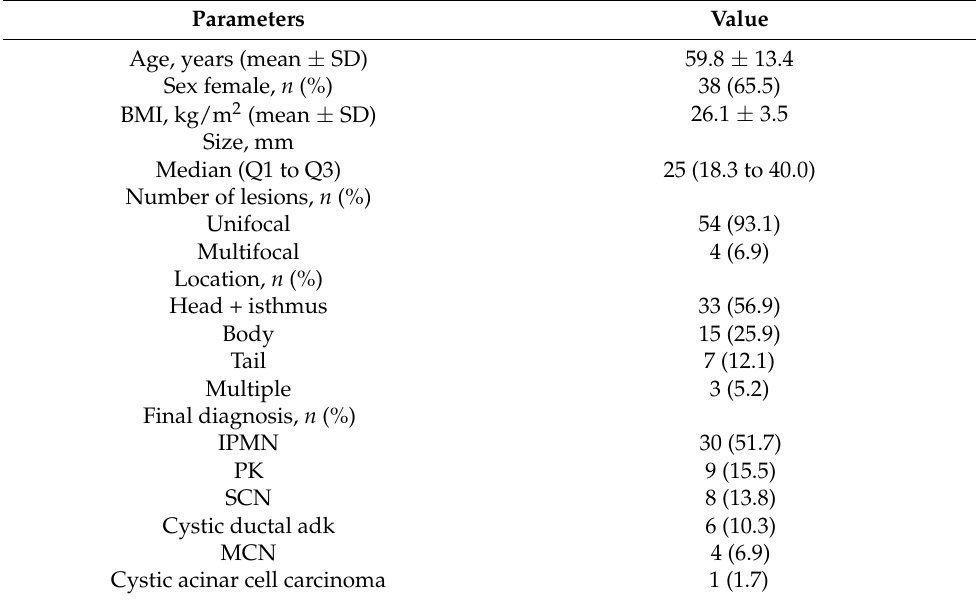
Table 1. Patients’ demographics and tumor